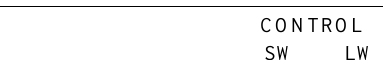
Table 2. Time- and area-averaged upward shortwave flux (SW) and longwave flux (LW) at the top of the atmosphere (TOA).